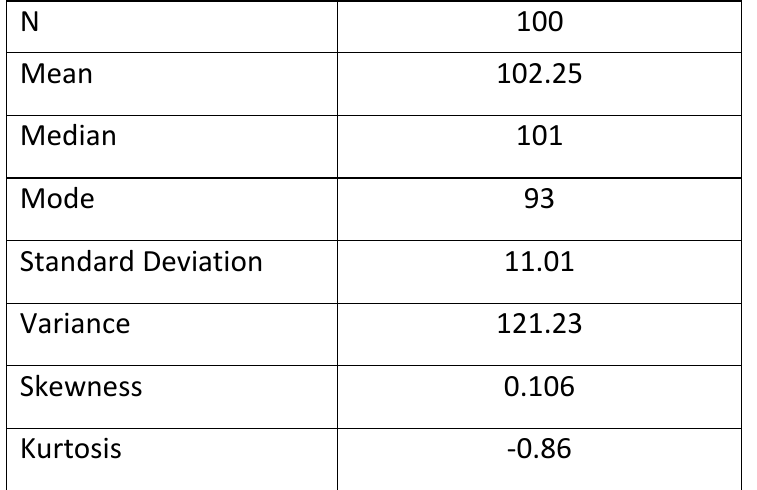
Table 3: Descriptive statistics of attitude of secondary teacher trainees towards entrepreneurial education